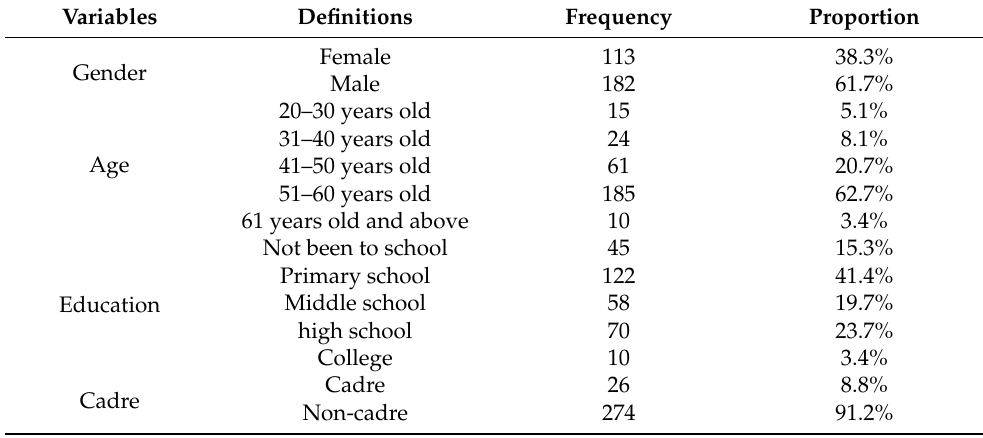
Table 1. Sample characteristics.